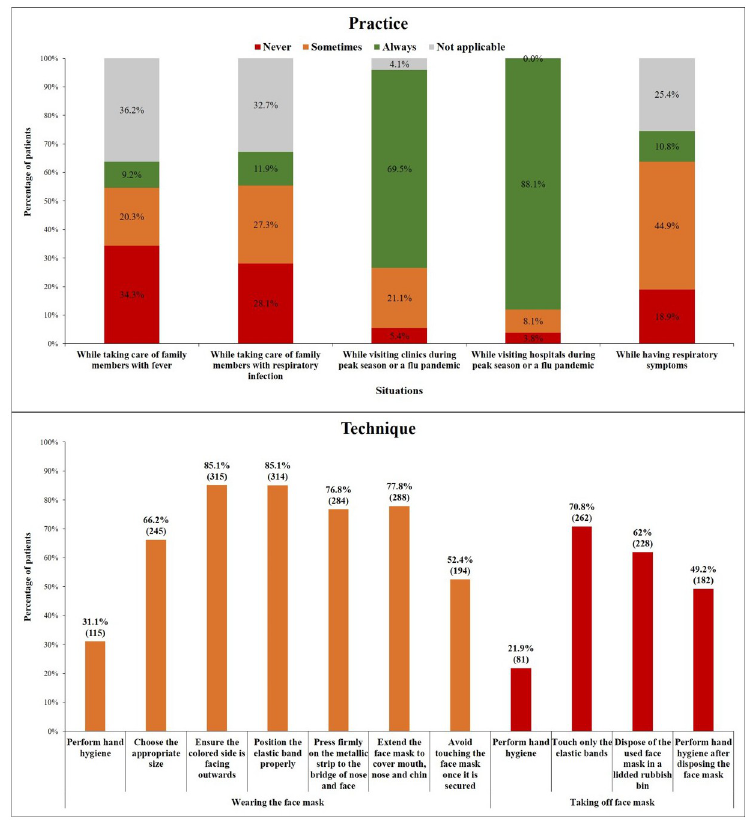
Fig 1. Distribution of practice of using face mask specific to various situations and technique of putting on and taking of face mask.